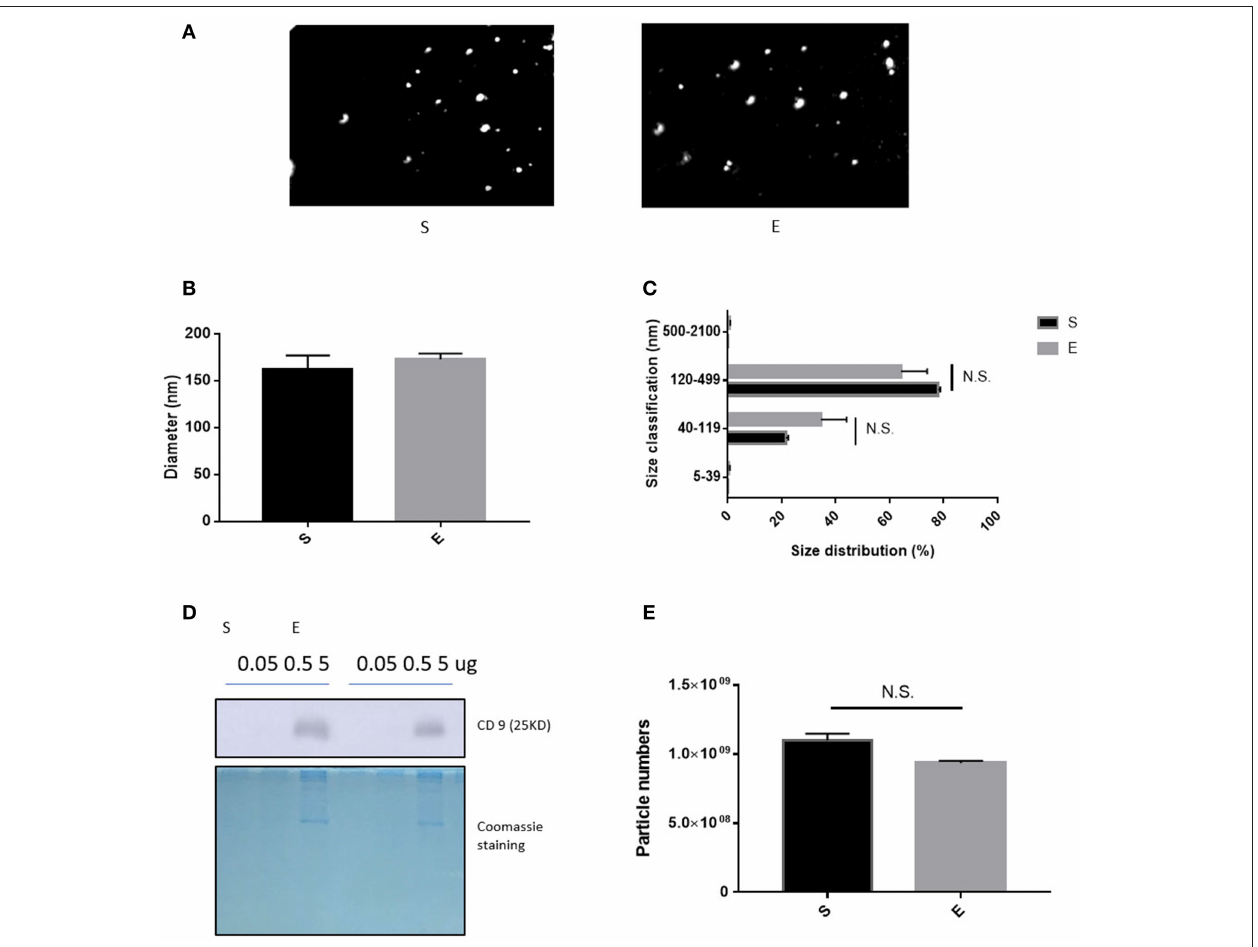
FIGURE 2 | The features of EVs induced by 4 weeks of voluntary wheel exercise. (A) A representative video frame. (B) The average diameter. (C) The size distribution. (D) Western blotting for CD9 (an EV-specific marker). (E) EV particle numbers. N.S., not significant. Statistical analysis was performed with the aid of the two-tailed Student t